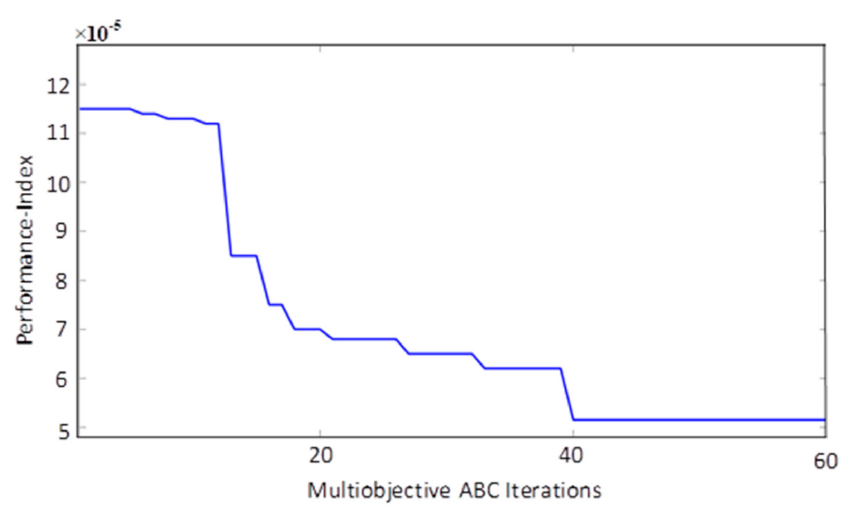
Figure 10. ABC algorithm performance for multiobjective optimization of Voltage-Source Con- verter (VSC).